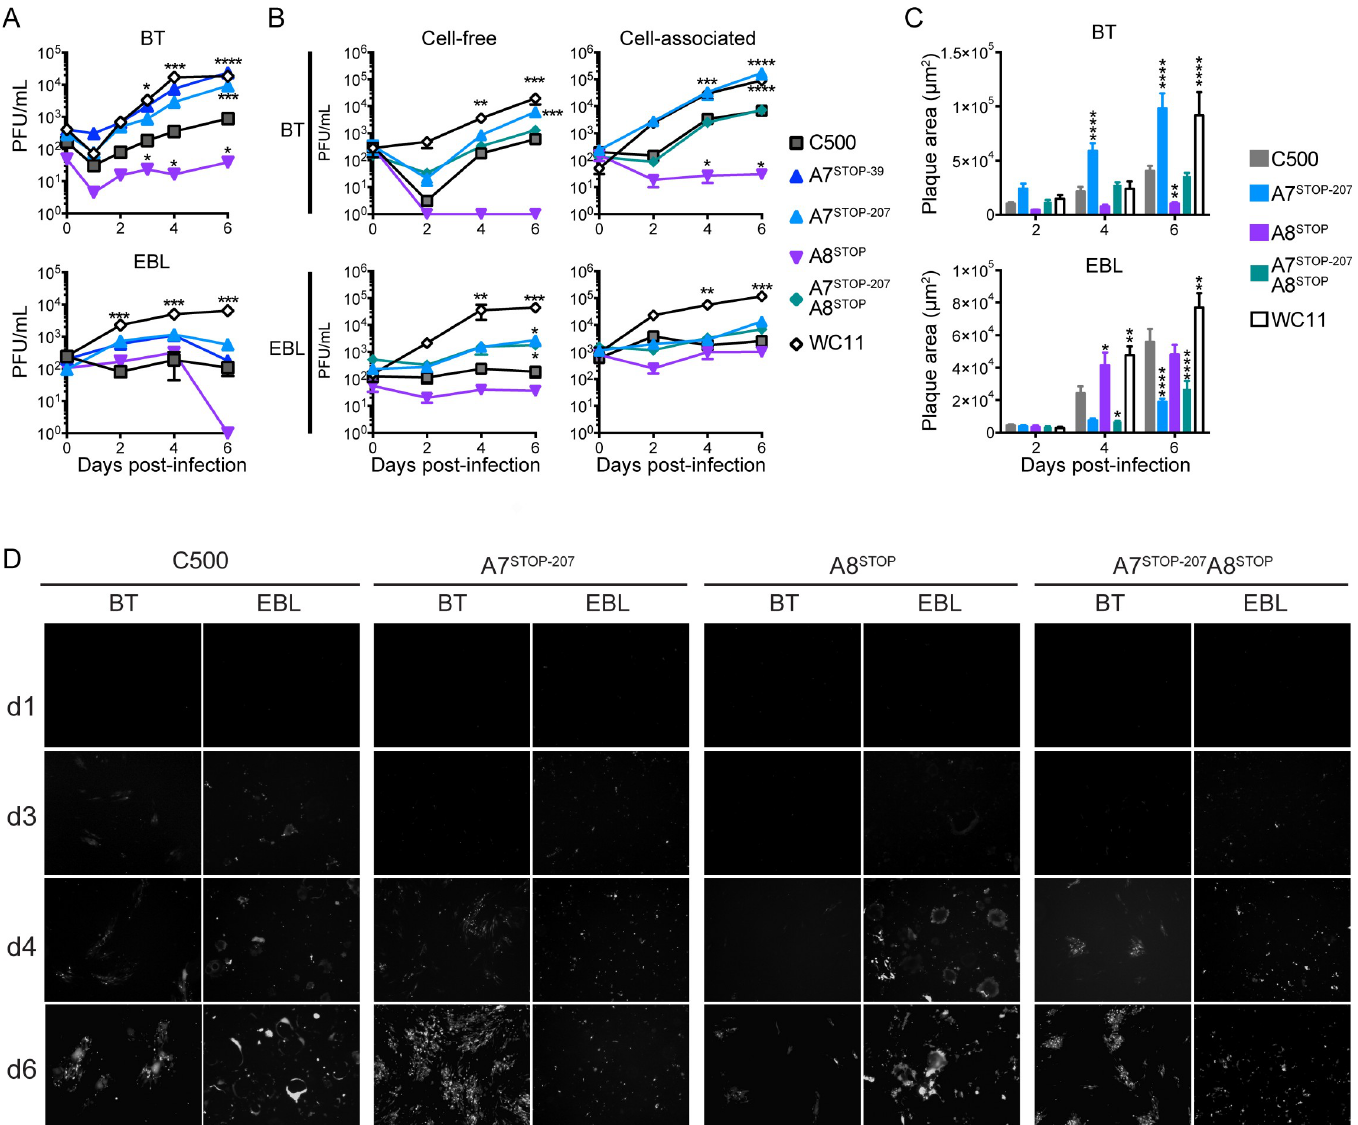
Fig 3. A7 and A8 expression regulate viral propagation. (A and B) Multistep growth curves of C500 BAC + WT, BAC + A7 STOP-39 , BAC + A7 STOP-207 , BAC + A8 STOP-159 , BAC + A7 STOP-207 A8 STOP-159 and WC11 in BT (top) or EBL (bottom) cells. Data are displayed as mean ± SD of measurements in triplicates. (A) Titers of cell-released and cell-associated infectious virions during infection. Plaque assays were performed on MDBK cells to quantify viral PFUs. (B) Titers of cell-released (left) and cell-associated infectious virions during infection. Plaque assays were performed on respective cell lines (BT or EBL) to quantify viral PFUs. (C) Infectious plaque areas during infection of BT (top) or EBL (bottom) cells. Data presented are mean ± SD of measurements in triplicates. (D) Microscopic analysis of viral propagation after infection of BT or EBL cells. Representative images are displayed for each time point after infection with C500 BAC + (WT), BAC + A7 STOP-207 , BAC + A8 STOP-159 or BAC + A7 STOP-207 A8 STOP-159 (m.o.i. = 0.01 PFU/cell). Infectivity was revealed by eGFP expression (white signals). Original magnification = 40 ×